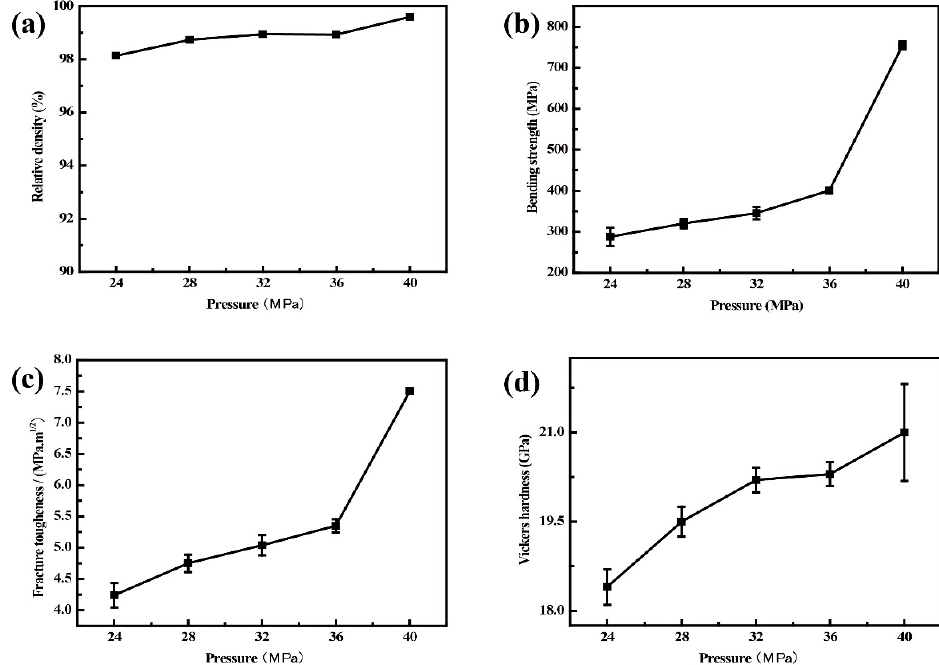
Figure 6. Changing trends of ( a ) relative density, ( b ) bending strength, ( c ) fracture toughness, and ( d ) Vickers hardness of Al 2 O 3 -G-M hot-pressed at different sintering pressure.